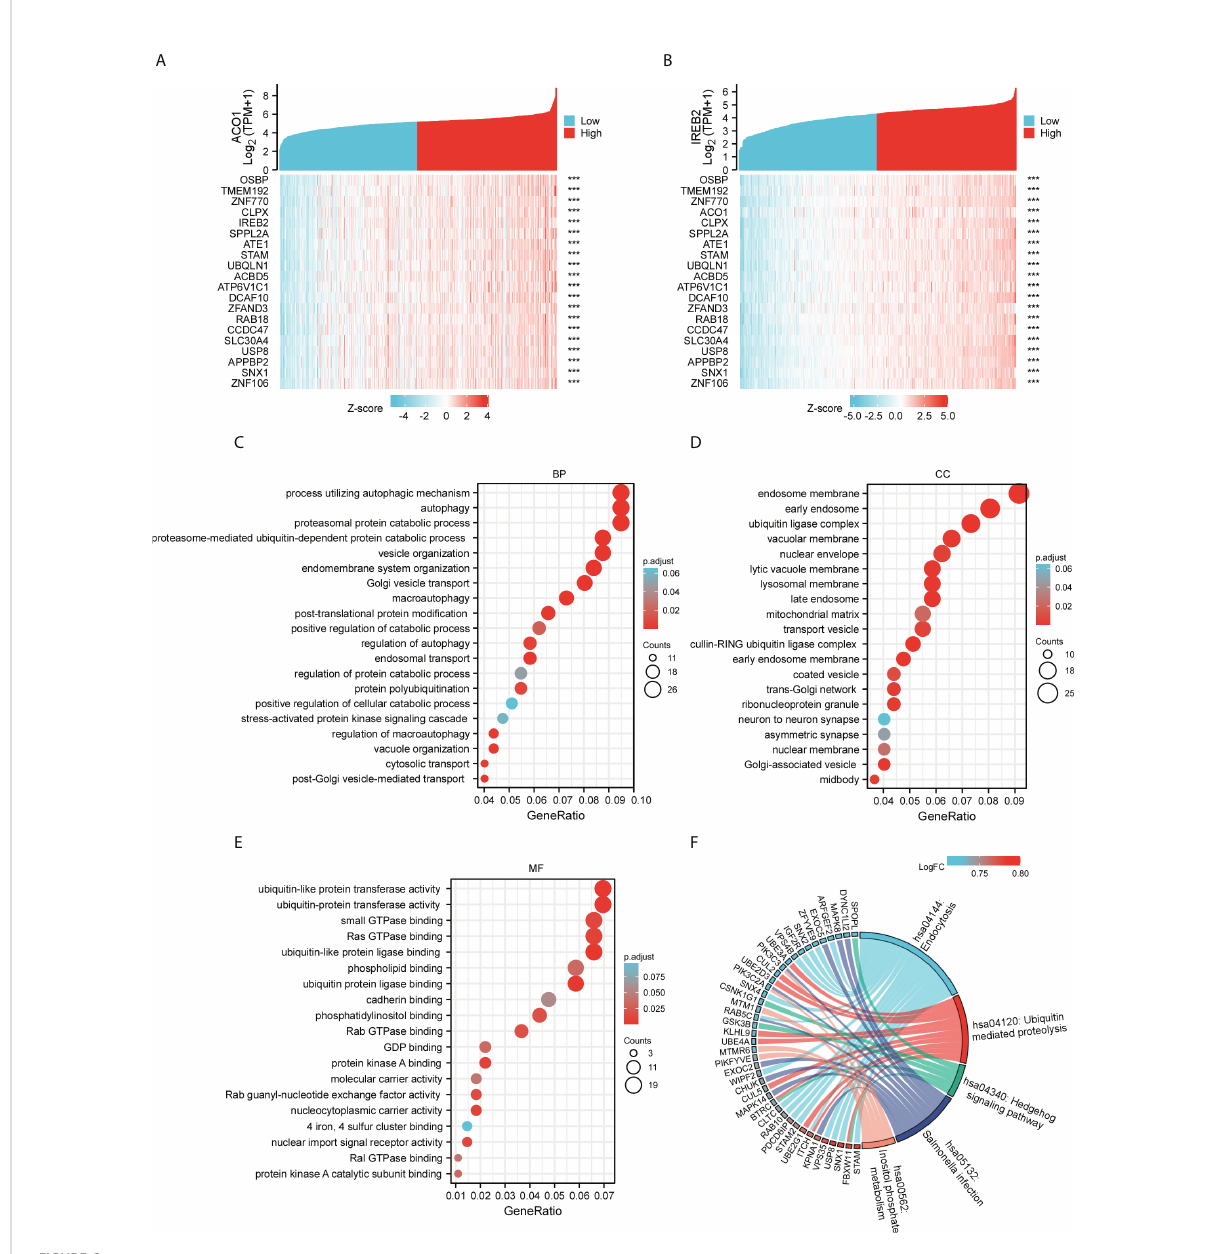
FIGURE 6 Gene Ontology (GO) and Kyoto Encyclopedia of Genes and Genomes (KEGG) enrichment analysis for ACO1 and IREB2 in TCGA-KIRC database. (A, B) Heat maps showing the top 20 coexpression genes positively correlated with ACO1 (A) and IREB2 (B) in KIRC. (C – E) Top 20 enrichment terms in BP (C) , CC (D) , and MF (D) categories in KIRC. (F) A chord diagram shows KEGG enrichment pathways in KIRC. GO: Gene Ontology; KEGG: Kyoto Encyclopedia of Genes and Genomes; TCGA, The Cancer Genome Atlas; KIRC, kidney renal clear cell carcinoma; BP, biological process; CC, cellular component; MF, molecular